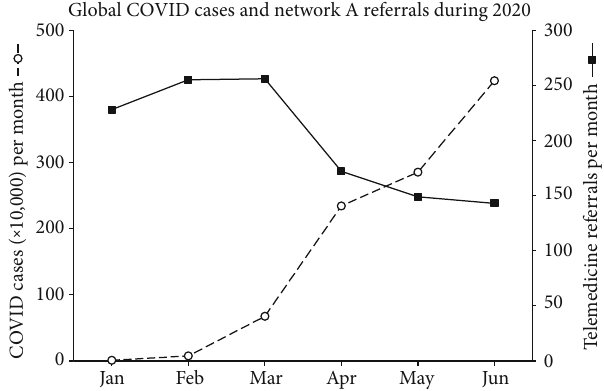
Figure 3: Global COVID cases during the fi rst half of 2020 and the referral rate on network